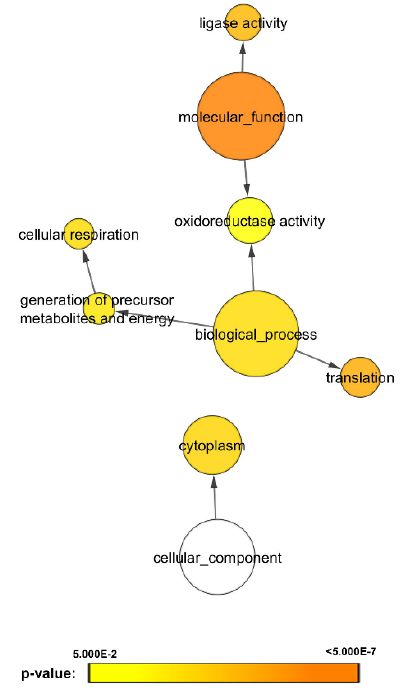
Figure 2. Gene ontology analysis of proteins commonly expressed in C. albicans biofilms. Analysis of overlapping differentially expressed proteins under bacterial stimulations revealed 164 proteins to be consistently downregulated and three proteins to be consistently upregulated. Biological processes, molecular functions, and cellular components were found to be significantly altered in C. albicans biofilms under stimulations of nine oral bacteria species; A. actinomycetemcomitans, A. naeslundii, F. nucleatum, E. faecalis, P. gingivalis, S. mutans, S. sanguinis, S. mitis , and S. sobrinus bacteria ( p -value < 0.05). The protein expression levels were represented in p -value using different colors: yellow (least significant) to orange (most significant). The white circle represents cellular component, a distinct aspect of how gene functions can be described.